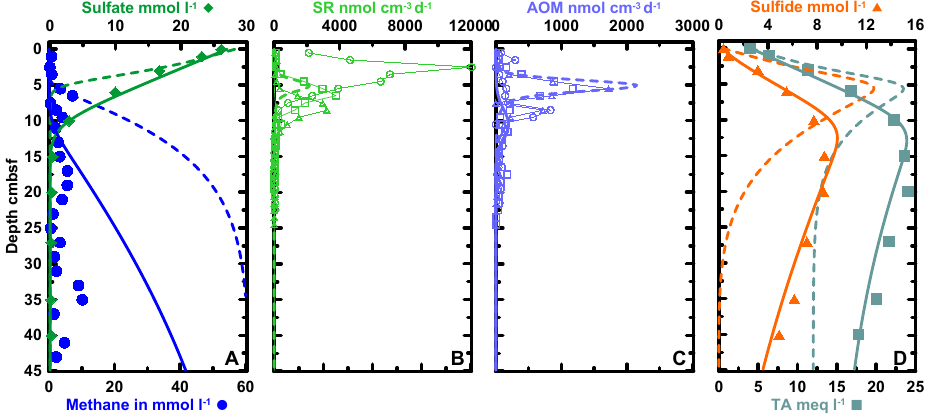
Figure 2. Depth profiles of measured and modeled porewater parameters and microbial turnover rates for SO206-31 (MUC) sampled from 401m water depth. Thick solid lines: pw-fit model; thick dashed lines: hf-fit model (for details see Results). (a) Measured (diamonds) and modeled (thick green lines) sulfate concentrations (per L porewater), as well as measured (circles) and modeled (thick blue lines) methane concentrations (per L sediment). (b) Three replicates (thin lines and symbols) of measured sulfate reduction rates (per cm − 3 sediment). (c) Three replicates of measured (thin lines and symbols) and modeled (thick lines) AOM rates (percm − 3 sediment). (d) Measured (triangles) and modeled (thick orange lines) sulfide concentration, as well as measured (squares) and modeled (thick grey lines) total alkalinity (per L